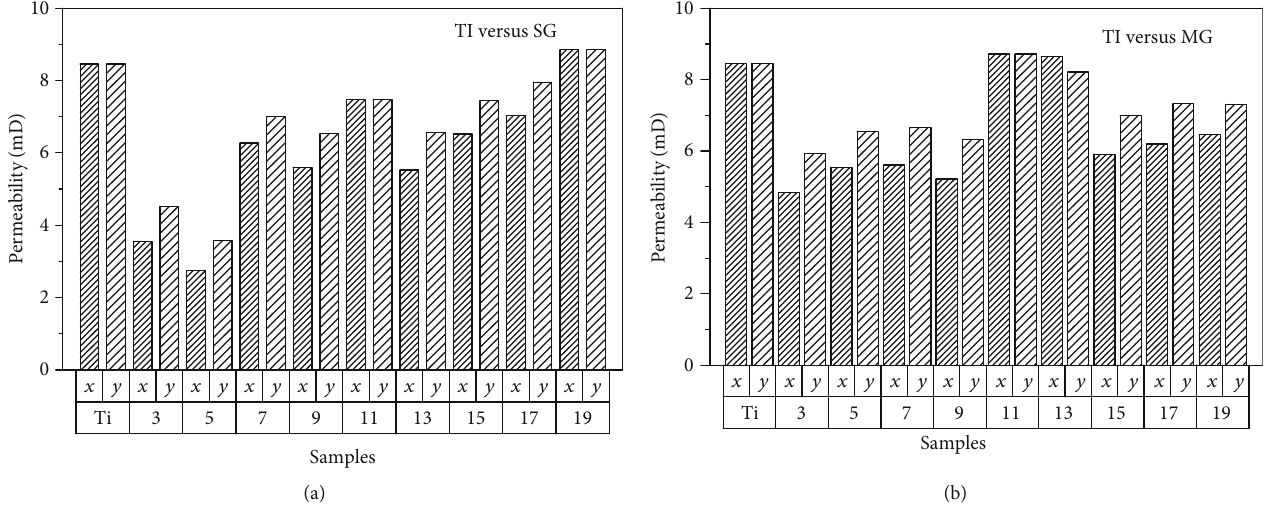
Figure 11: Permeability: (a) single-grid scheme; (b) multiple-grid scheme.